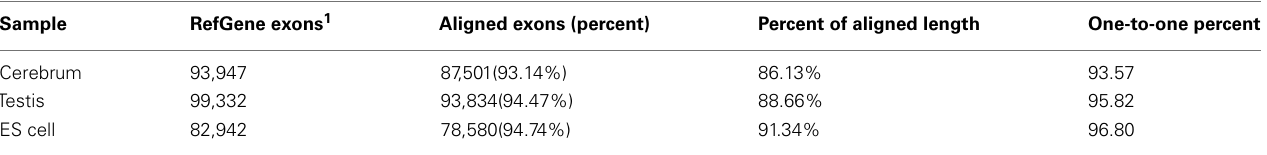
TableA2 |The evaluation of exon identification.